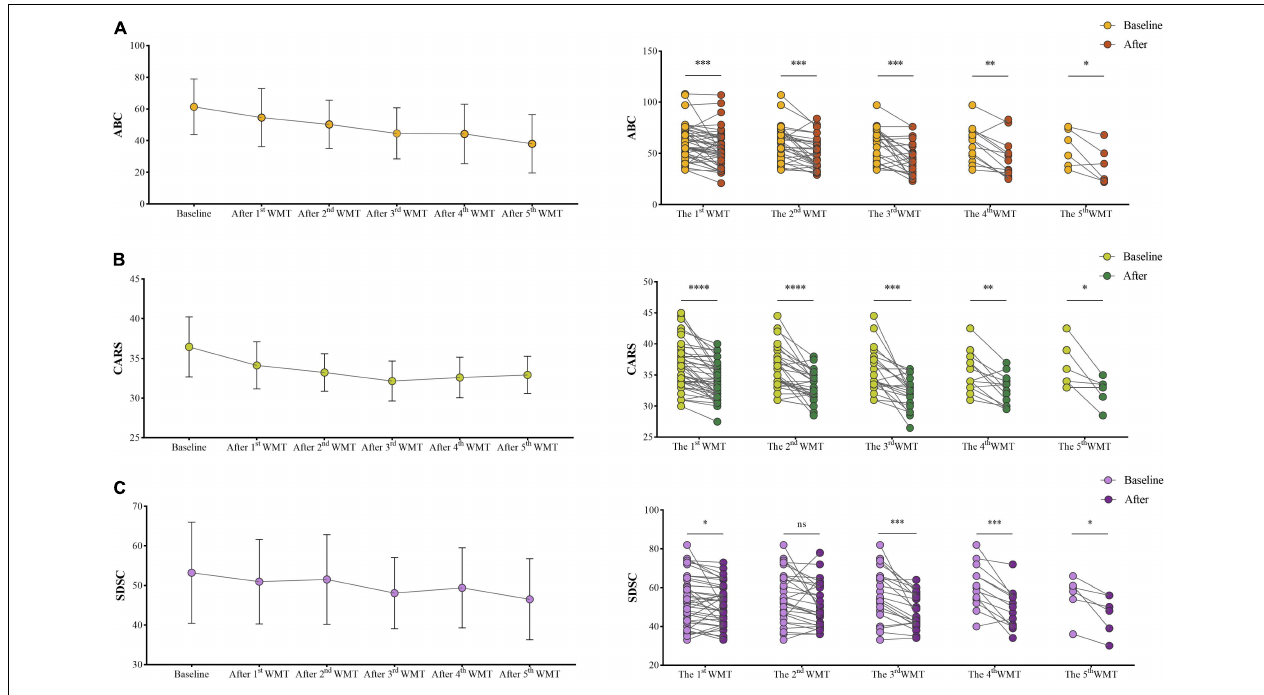
FIGURE 2 | Effect of WMT on ASD symptoms and sleep disorders. Changes in ABC (A) , CARS (B) , and SDSC (C) scores. The line chart shows the means and standard deviation of the data. Paired data from each course are compared with their primary baseline. ABC, Aberrant Behavior Checklist; CARS, Childhood Autism Rating Scale; SDSC, Sleep Disturbance Scale for Children; WMT, washed microbiota transplantation. Statistical analysis was performed using paired Student’s t -tests or Wilcoxon signed-rank tests. ∗ P < 0.05; ∗∗ P < 0.01; ∗∗∗ P < 0.001; ∗∗∗∗ P < 0.0001; ns P > 0.05 not significant.